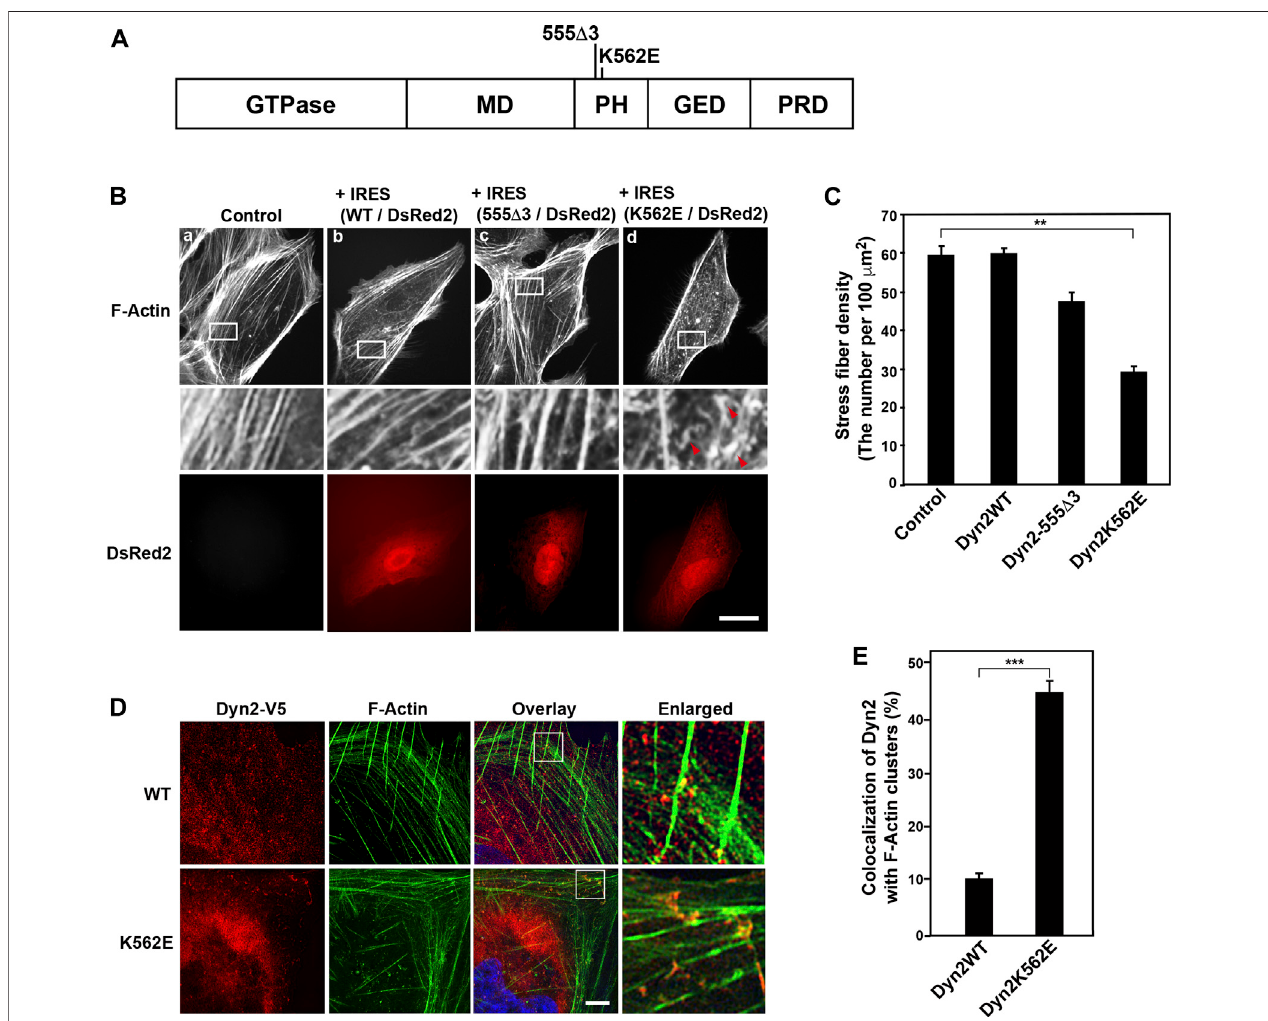
FIGURE 1 | Expression of the dynamin 2 (Dyn2)-K562E mutant leads to the formation of aberrant actin bundles and a decrease in stress fi ber density in human podocyte cells. (A) Domain structure of dynamin 2 and the location of the 555 Δ 3 and K562E mutations in rat dynamin 2. GTPase domain, MD = Middle Domain; PH = PleckstrinHomologydomain;GED=GTPaseEffectorDomain;PRD=Prolinearginin-RichDomain. (B) AlexaFluor488-phalloidin-labeledactin fi lamentsinHPCs.HPCs were transfected with dynamin 2-WT (WT) (b) , 555 Δ 3 (c) , or K562E (d) expression constructs cloned into the pIRES-DsRed2 vector. Non-transfected cells (Controls)areshownin (a) .Whiterectangularareasinthetoppanelscorrespondtoenlargedimagesinthemiddlepanels.Stress fi bersareclearlyobservedincontroland dynamin 2-WT-expressing cells. Note the reduction in actin bundles and stress fi bers, and the presence of F-Actin clusters (red arrowheads) in K562E mutant- expressing cells (d) . Dynamin-transfected cells were identi fi ed by DsRed2 expression (bottom panels). Actin clusters were shown by arrowheads. Scale bars: 20 μ m in top and bottom panels and 3.6 μ m in middle panels. (C) Stress fi ber density in control HPCs and those expressing the various dynamin 2 constructs. Data are means ± S.E.M.of 33cells (control), 101 cells (dynamin 2-WT), 39cells (dynamin2-555 Δ 3)or105cells (dynamin 2-K562E) from three independent experiments. (** p < 0.01). (D) Super-resolution microscopy images of V5-tagged dynamin 2-WT or K562E, and actin fi laments (F-Actin) in HPCs processed by double-immuno fl uorescence. White squares in the overlay images correspond to the enlarged images on the right. Scale bars: 5 μ m, 1 μ m in enlarged panels. (E) Quanti fi cation of the colocalization of dynamin 2-WT or K562E, and actin fi laments in HPCs. Data are mean ± S.E.M. of 51 cells in dynamin 2-WT and 50 cells in K562E from three independent experiments. For each sample, colocalization was determined in three randomly selected areas per cell (21 μ m 2 ). (*** p < 0.001).